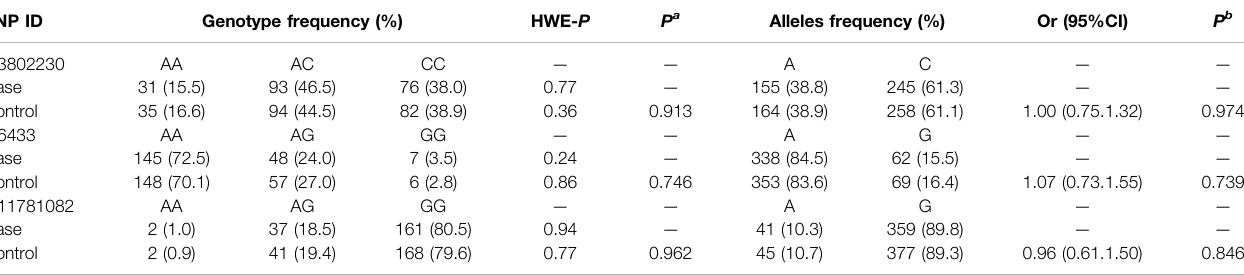
TABLE 5 | Genotype and allele frequency of CYP11B2 polymorphism between EH and healthy control patients and their relationship with EH risk in the Mongolian population. SNP ID